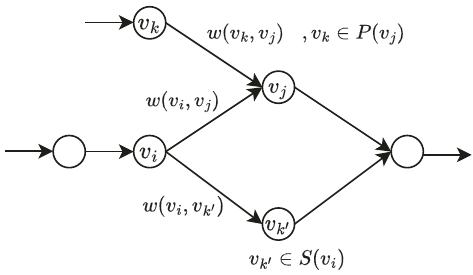
Fig. 4 | A schematic diagram for explaining the calculation of Support and Con fi denceforedge( v i , v j ). w ( v i , v j )istheapproximationfortheexpectedamount of reads that cover edge ( v i , v j ). S ( v i ) and P ( v j ) denote the vertices that succeed v i and precede v j , respectively. In this directed graph, v j , v k 0 are the successors of v i , whereas v i , v k are the predecessors of v i